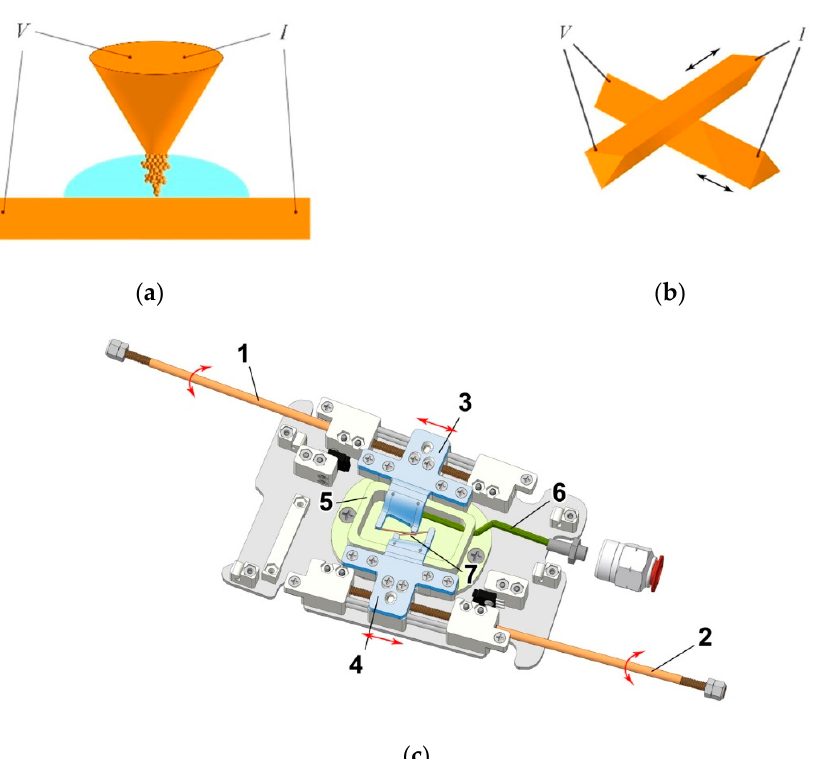
Figure 3. Schematic image of cartridge, as part of the laboratory prototype of the device for multipurpose research on dendritic Yanson point contacts and quantum sensing, which allows the creation of Yanson point contacts using both the needle–anvil and Chubov displacement techniques. ( a ) Schematic view of the dendrite growth in the framework of the needle–anvil method. ( b ) Schematic view of the Chubov displacement technique. ( c ) Cartridge. 1, 2, manipulator rods; 3, 4, electrode holders; 5, cuvette; 6, capillary; 7, production of a Yanson point contact using the Chubov displacement technique. I , current, V , voltage.